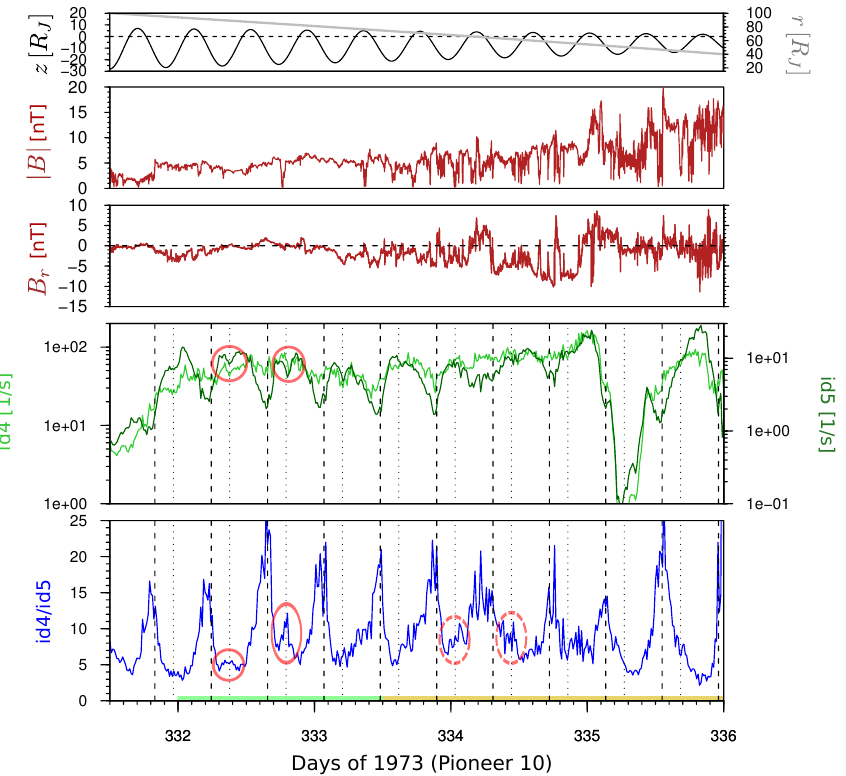
Fig. 7. Magnetic field and particle data of Pioneer 10 during the spacecraft’s inbound trajectory similar to Figs. 2 and 3. Events that can be interpreted as minor peaks are indicated by red ellipses in the bottom panel. The ellipses in the panel showing the id4 and id5 counting rates indicate the corresponding local minima. The dashed ellipses in the time series showing the spectral index indicate questionable events with no clear counterparts (i.e. local minima) in the counting rates. Note, however, that most of the time local minima on top of the global count rate maxima can be identified. The green and yellow shades on the bottom of the figure indicate two time intervals analysed independently. ranks of the individual data points of the H3 / H5 ratio as a function of the System III longitude in a colour-coded way. The abscissa is the System III longitude at the subsolar point of the Jovian magnetosphere; the ordinate indicates the num- ber of rotations of the planet (starting with rotation #1 at day 34 and ending at day 38.5). In this representation, the use of local ranked values instead of using the absolute val- ues of H3 / H5 has the advantage that subtly nuanced vari- ations can be emphasised. To interpret this figure, note that the red squares indicate that the actual data point has a higher rank than its predecessor 10, while green indicates a lower rank (i.e. a decreasing of the H3 / H5 ratio). A lower rank (i.e. the local maxima of the H3 / H5 ratio) occurs when the colour switches from red to green. On the one hand, this fig- ure clearly illustrates the well-known 10 h modulation (i.e. a maximum in the spectral index if the System III longitudes λ III = 240 ◦ –310 ◦ face the subsolar point). On the other hand, the presence of the minor peaks with a local maximum of the spectral index can be identified at System III longitudes λ III = 40 ◦ –100 ◦ in agreement with the respective time